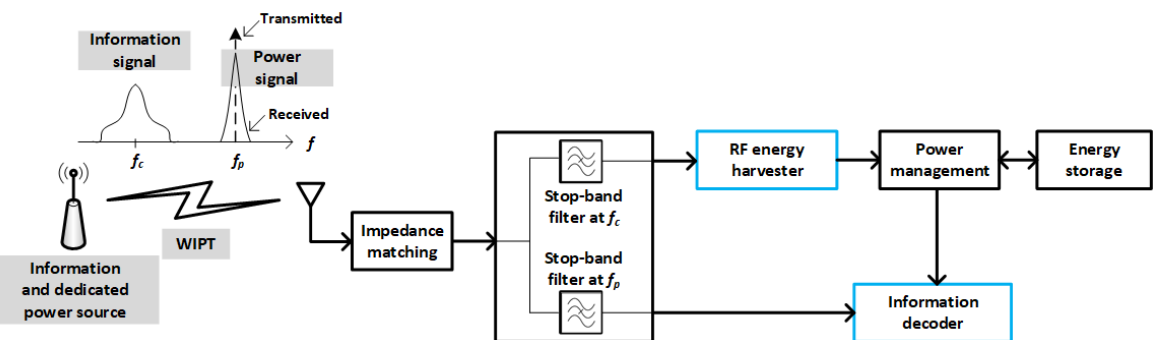
Figure 3. Frequency-splitting architecture. This architecture is really a variant of WIPT, because information and power are transferred via separated signals in the frequency domain, but just a single antenna is required at each side of the link (as in SWIPT).